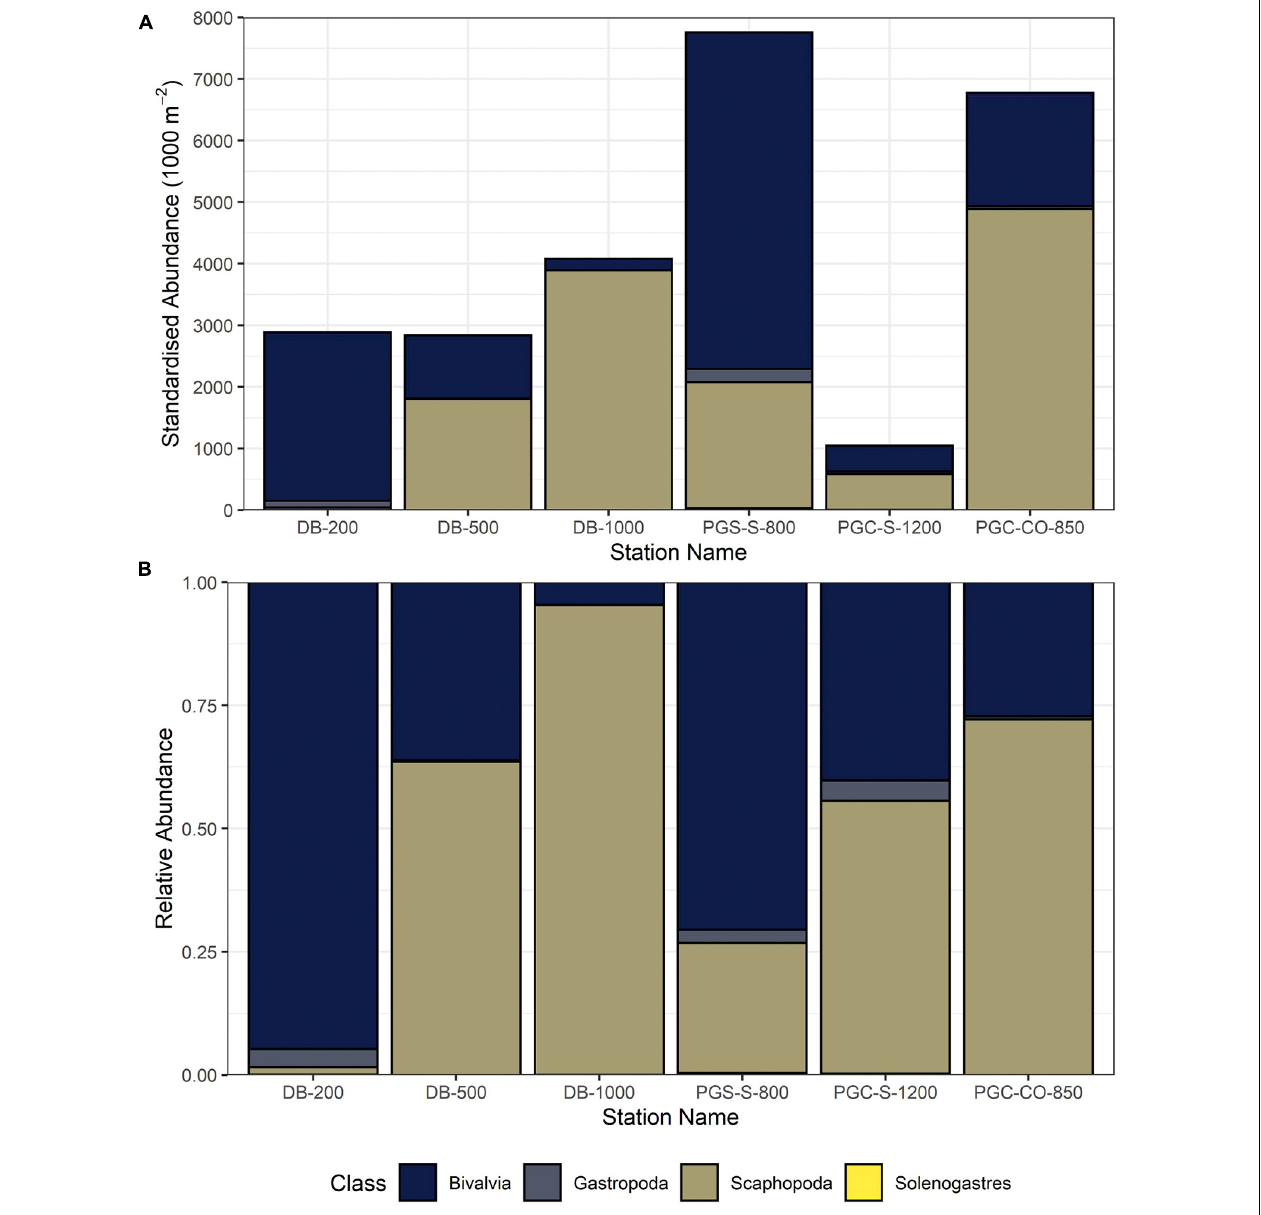
FIGURE 2 | Relative and standardised abundances of molluscan classes by station (DB, Duse Bay; PGC, Prince Gustav Channel; S, South; CO, Cape Obelisk). (A) Relative abundances. (B) Standardised abundances (per 1,000 m 2 ) of molluscan